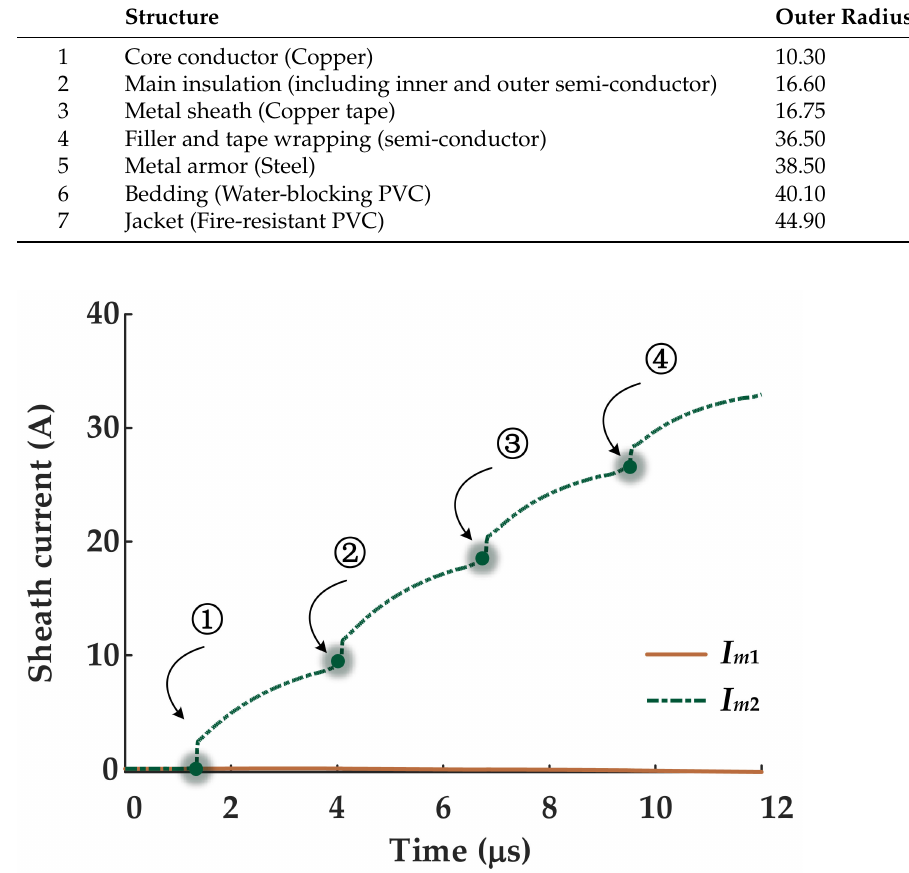
Figure 10. The sheath currents monitored by the current sensors at the two ends. ( 1 (cid:13) ~ 4 (cid:13) represent the traveling wave steps no.1 to